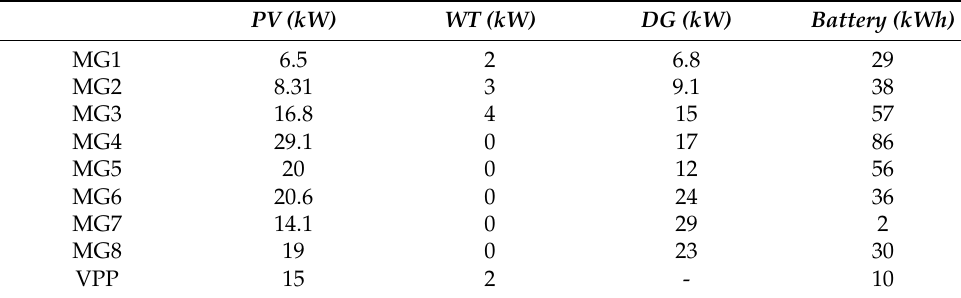
Table 1. Component size of MGs and VPP.